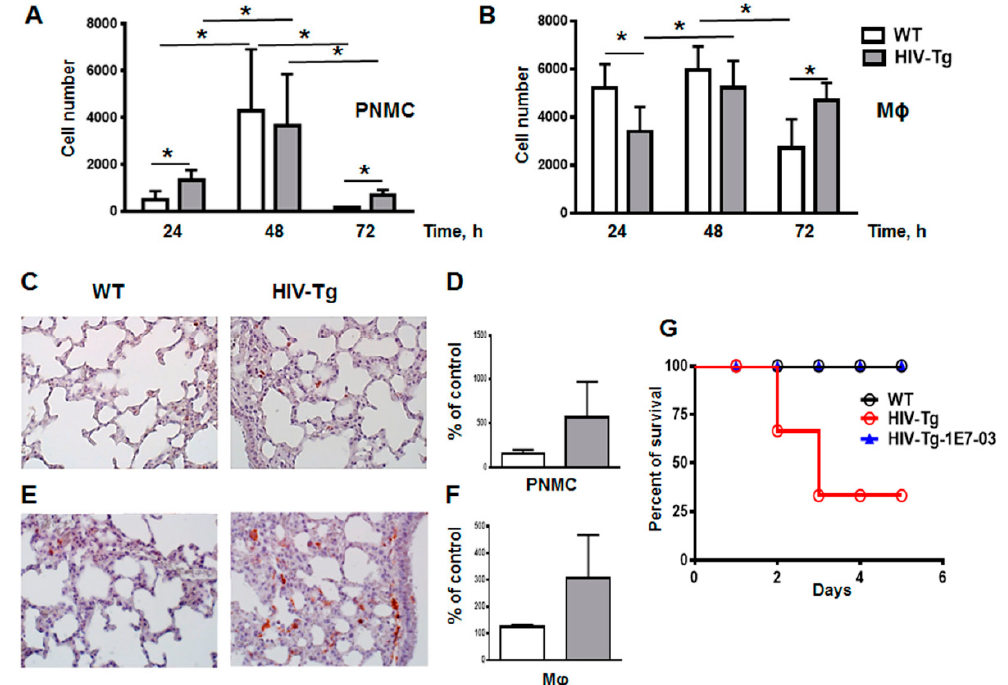
Figure 5. Resolution of lung inflammation is delayed in HIV-Tg mice. ( A , B ) Time course of resolution of lung neutrophil (A, PMNC) and macrophage (B, M φ ) infiltration in WT (white color) and HIV-Tg (grey color) mice detected by flow cytometry. Asterisk indicates * p < 0.05. ( C , D ) Immunostaining (panel C, red color) and quantification (panel D) of lung neutrophils. Results are shown as percent of WT-PBS level. Mean and standard error are shown. Hematoxylin is used for counterstaining (purple nuclear staining). Original magnification is 400 × . ( E , F ) Immunostaining (panel E, red color) and quantification (panel F) of lung macrophages. Results are shown as percent of WT-PBS level. Mean and standard error are shown. Hematoxylin is used for counterstaining (purple nuclear staining). Original magnification is 400 × . ( G ) Survival of WT (black) and HIV-Tg mice (red) after administration of LPS and subsequent IP injection with 1E7-03 (blue). N = 9 for HIV-Tg mice, N = 10 for WT mice and N = 6 for HIV-Tg mice injected with 1E7-03 (HIV-Tg-1E7-03).